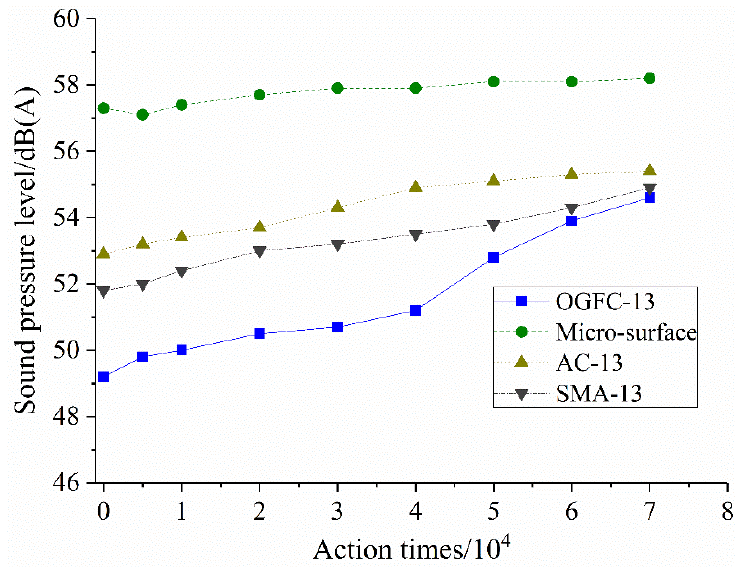
Figure 10. Pavement long-term noise characteristics.